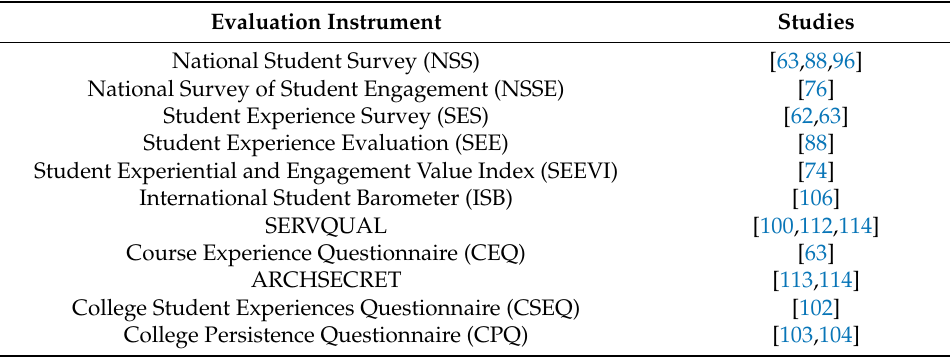
Table 6. Instruments to evaluate SX